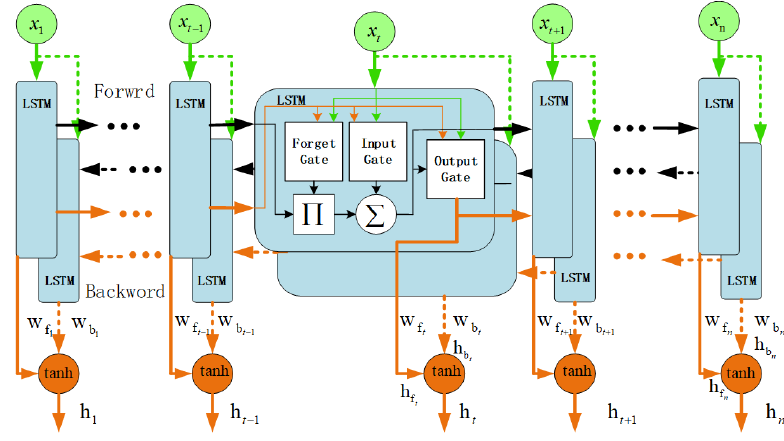
Figure 9. The Flow Diagram of BiLSTM.